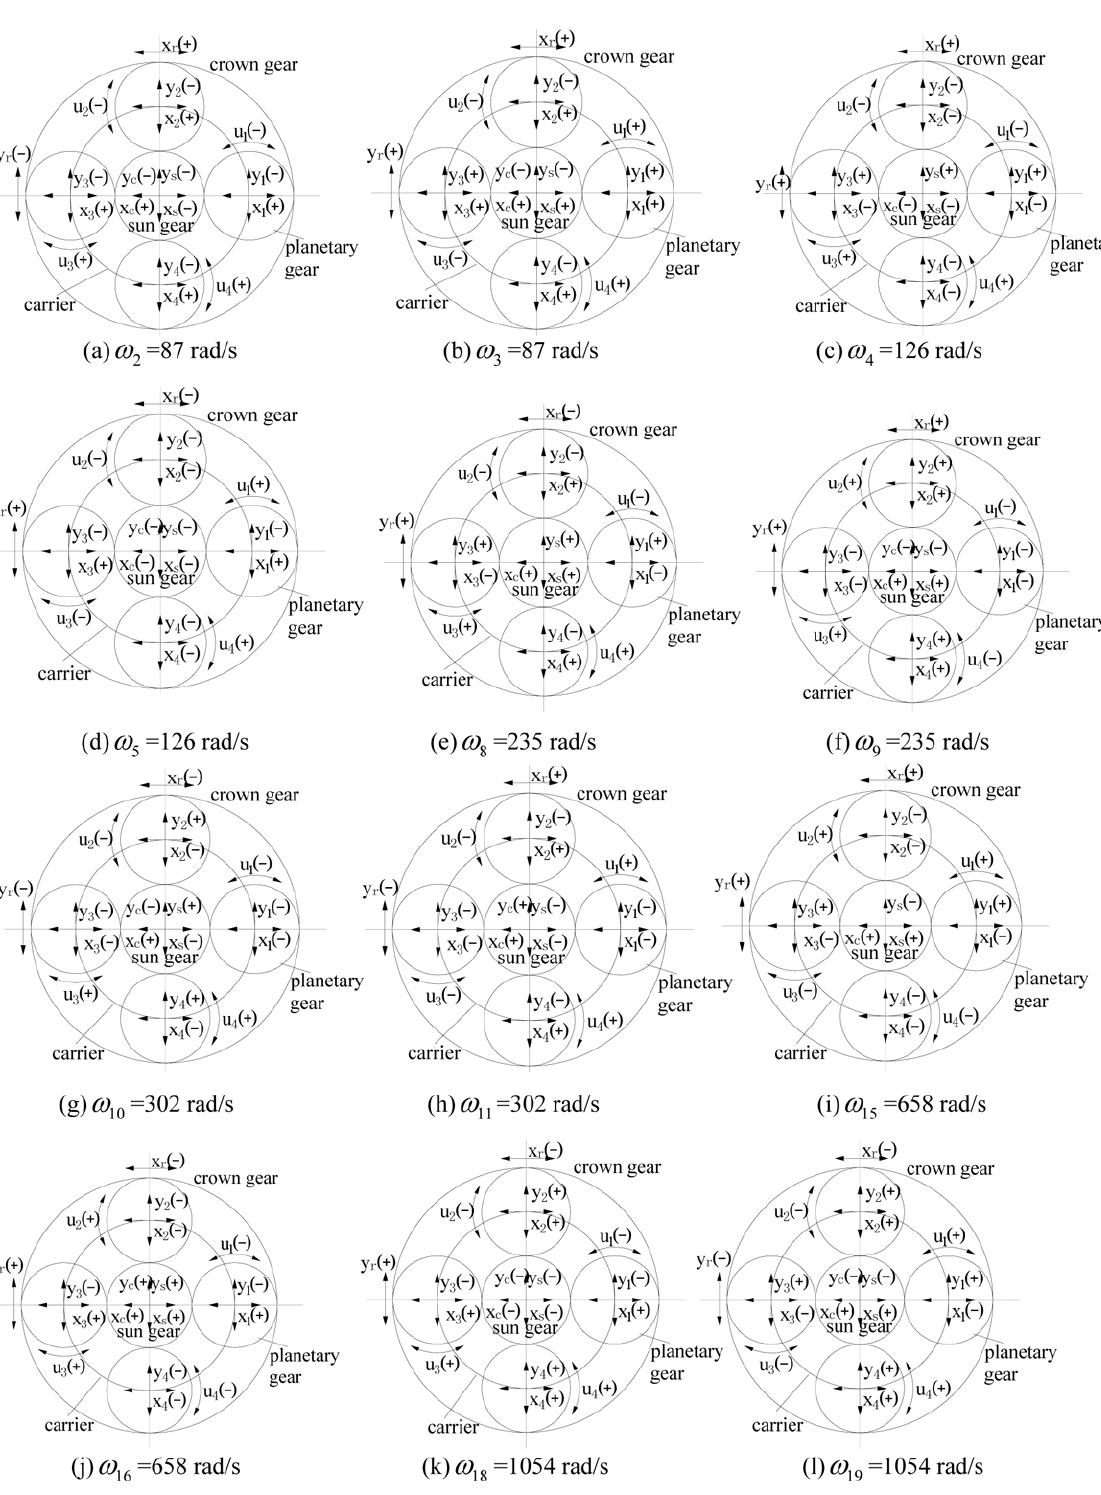
Fig. 5. Translation modes of the central elements ( N =